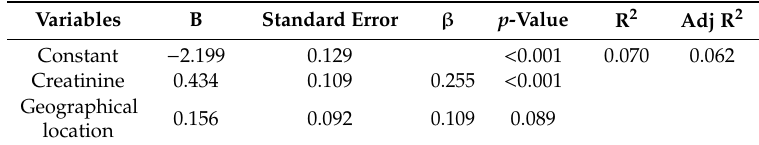
Table 4. Results of the multiple linear regression